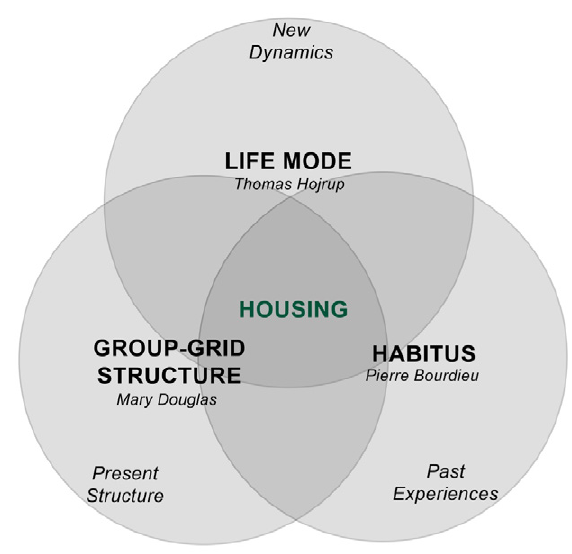
Figure 2. The triadic perspective of lifestyles theories for understanding housing developments, typologies, and